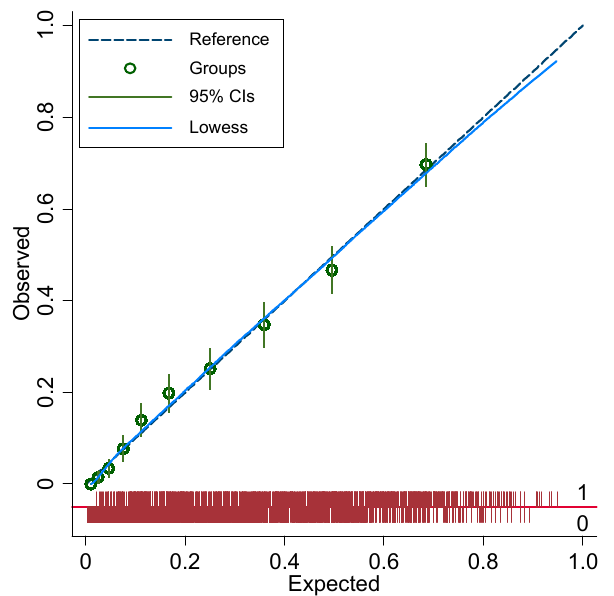
Figure 5. Calibration plot for the multivariable logistic regression model in people with primary discharge diagnosis of diabetes. Each decile is denoted by a circle with a short intersecting line to indicate the corresponding 95% confidence interval. The diagonal smooth line (Lowess) indicates excellent agreement between the observed and expected values.